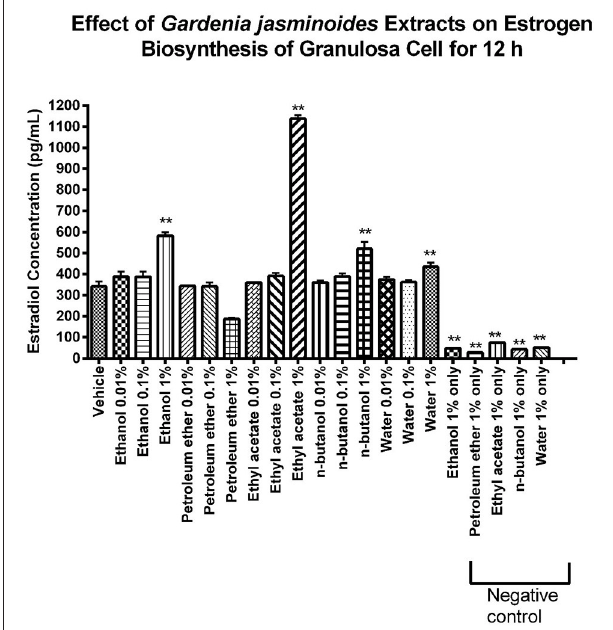
FIGURE 7 | Identification of the GJE- derived bioactive fraction with estrogen stimulating effect using phenotypic screening. Effects of GJE fractions on production of estrogen in granulosa cells after 12h of treatment were determined by estradiol assay. Each value represents mean ± SEM ( n = 3), ** p < 0.01, One-way ANOVA Dunnett’s Multiple Comparison Task.